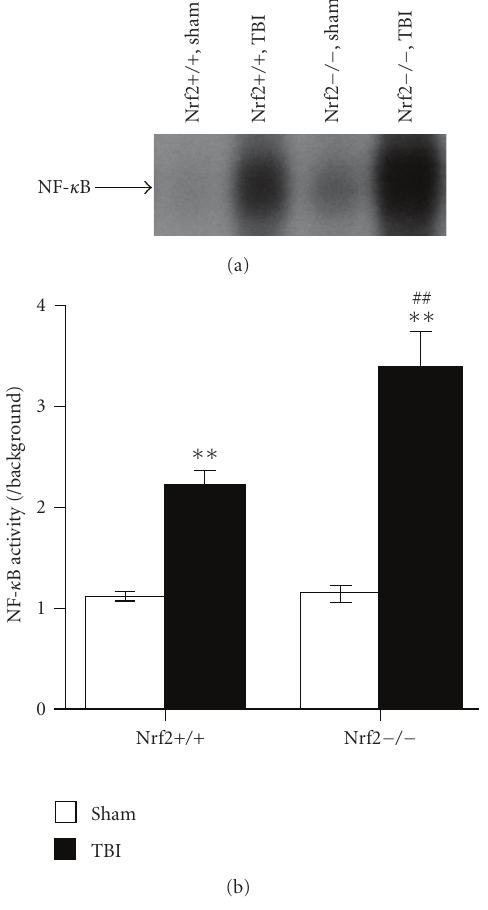
Figure 2: NF- κ B activity in the cortex of sham and injured Nrf2 (+/+) and Nrf2 ( − / − ) mice. (a) Nuclear proteins of brain samples of Nrf2 (+/+) and Nrf2 ( − / − ) mice were assayed for NF- κ B DNA binding activity by EMSA 24 hours after TBI. (b) Quantification of NF- κ B DNA binding activity was performed by densitometric analysis. The figure indicates that cerebral NF- κ B activity was significantly increased after TBI and was greater in Nrf2 ( − / − ) mice than in Nrf2 (+/+) mice. Data represents mean ± SEM ( n = 5 per group). ∗∗ P < . 01 versus sham control of the same genotype. ## P < . 01 versus injured wild-type